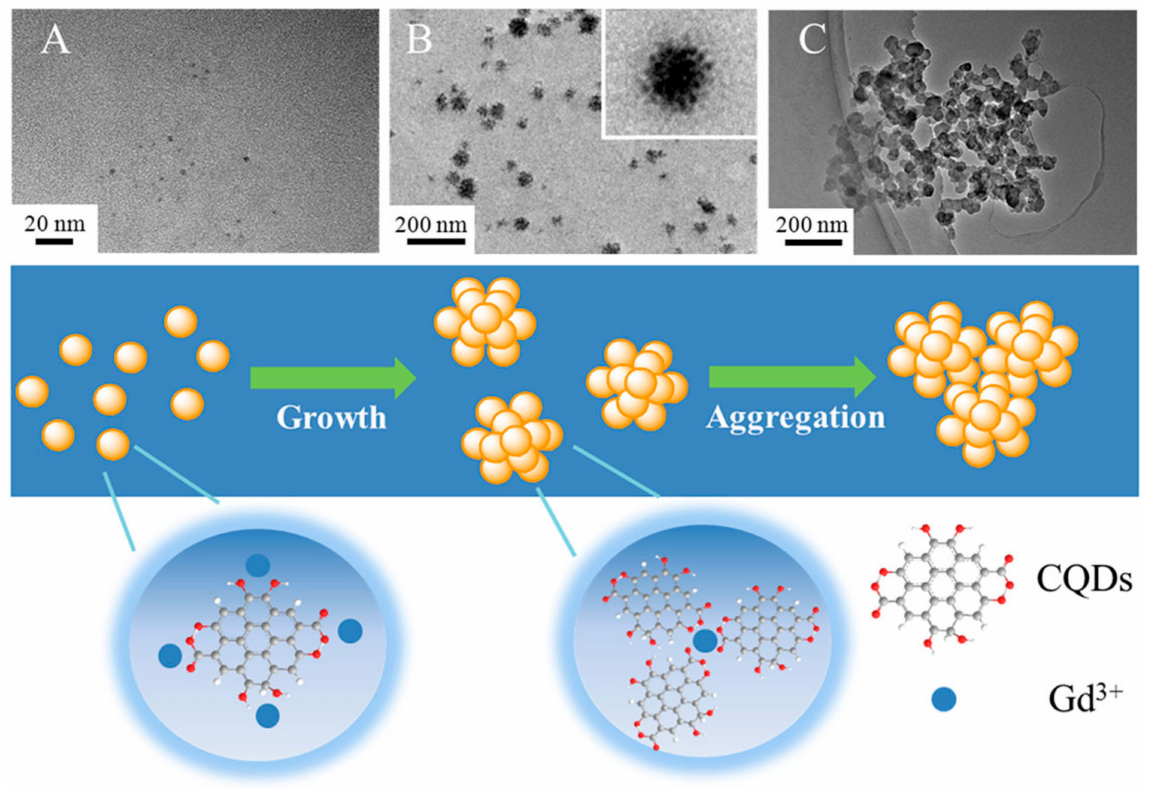
Figure 7. ( A ) TEM photos of the hydrothermal products after varied incubation durations, in- cluding ( A ) 1 h, ( B ) 3 h, and ( C ) 5 h, as well as a schematic illustration of the process of Gd–CQD synthesis [113].